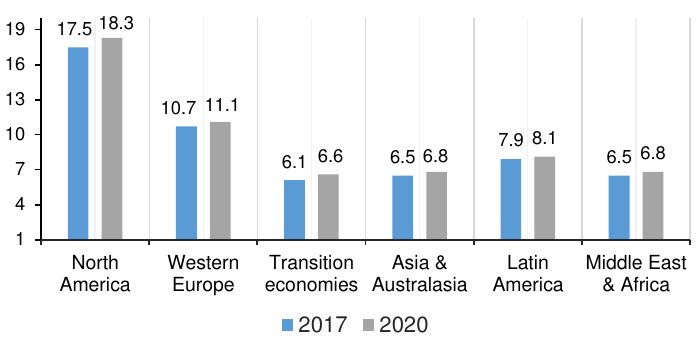
Figure 7. Region-wise comparison of healthcare spending (as a percentage of of GDP) in 2017 and projected expenditure in 2020. (Adapted from: